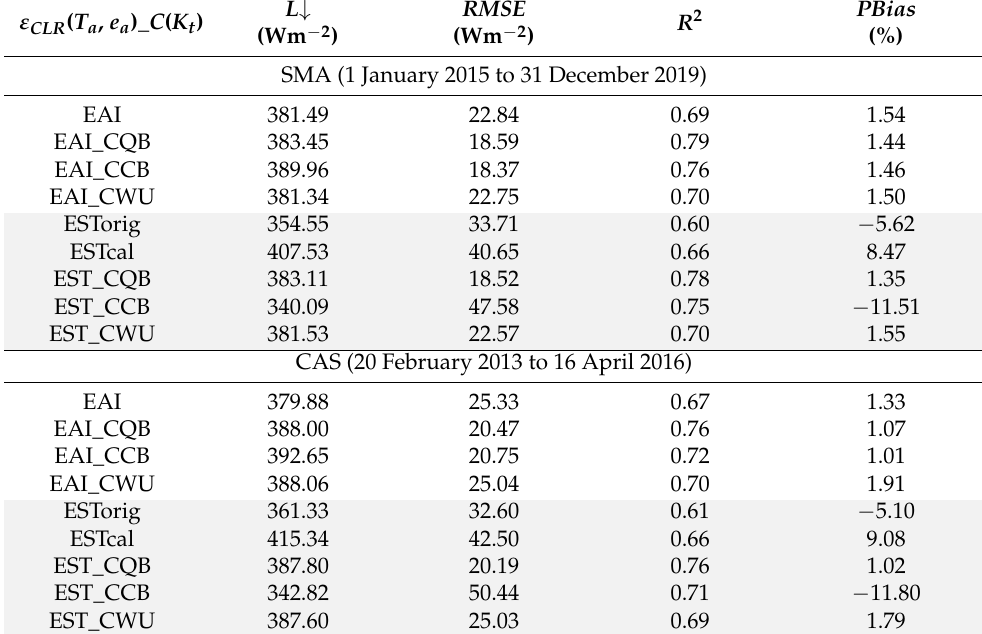
Table 7. Mean L ↓ estimated by the EAI and EST equations using coefficients for the entire